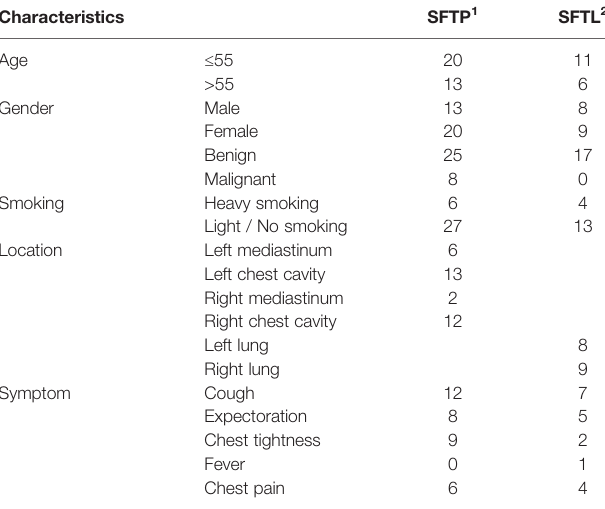
TABLE 1 | Baseline characteristics of patients. Characteristics